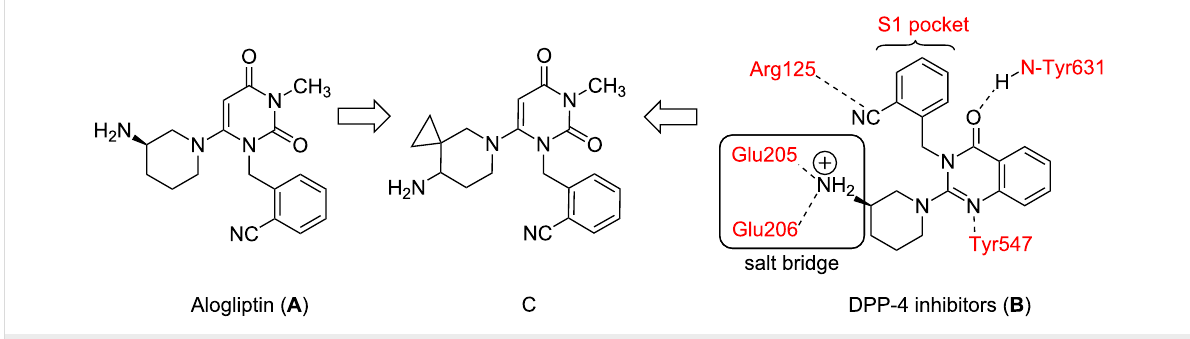
Figure 1: Design of a new DPP-4 inhibitor ( C ) based on Alogliptin ( A ) and other inhibitors ( B ).